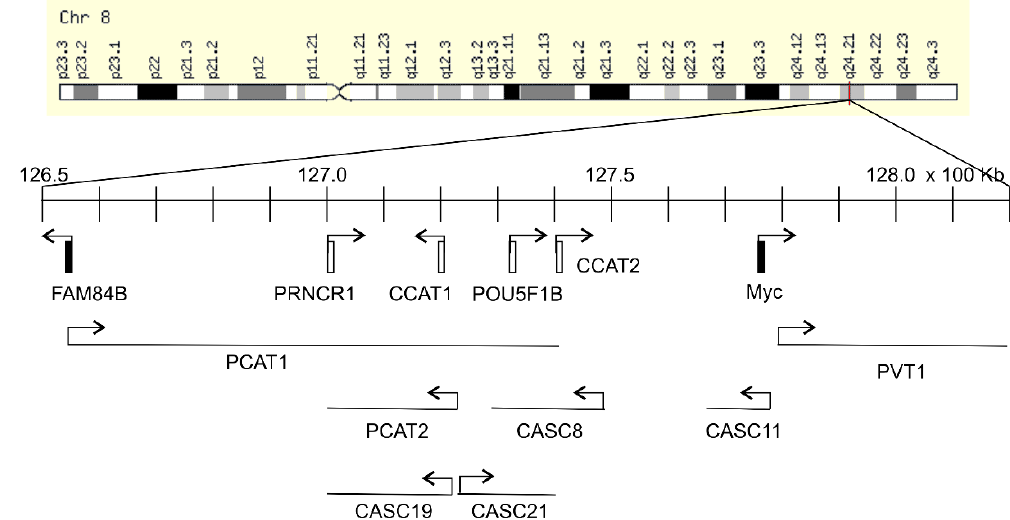
Figure 1. 8q24.21 gene desert. The chromosome 8 image was reproduced from MYC GeneCards. The location of indicated gene and transcription direction are indicated. The gene location is defined by the Genome Reference Assembly Human Genome build 38 (GRCh38/hg38), which might be different from previous publications in which the loci of these genes were based on GRCh37/hg19 (an older version). The precise locations are LRATD2 (FAM84B, 126,552,438–126,558,478bp), PCAT1